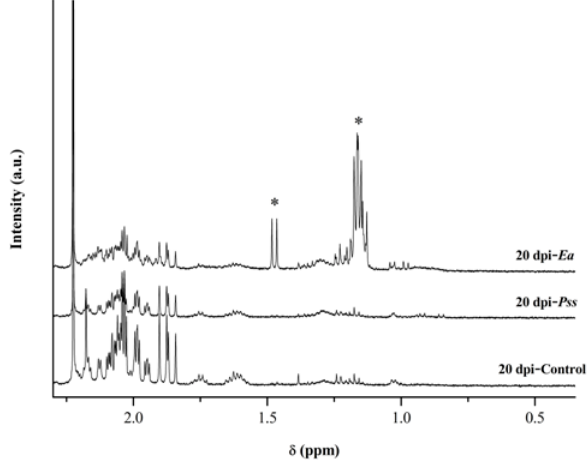
Figure 7. Contour plot resulting from the HR-NMR covari- ance analysis applied to control pear leaf samples at differ - ent plant growth